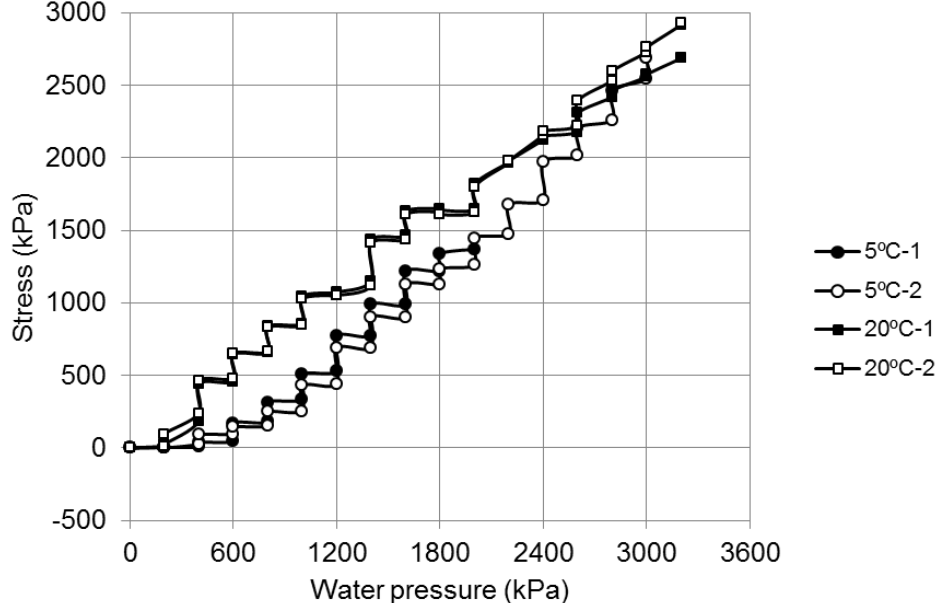
Figure 5. Induced average stress versus water pressure for the asphalt specimen with air porosity of 8.0% in the middle part under the vertical displacement restraint conditions at 5 °C and 20 °C, respectively.